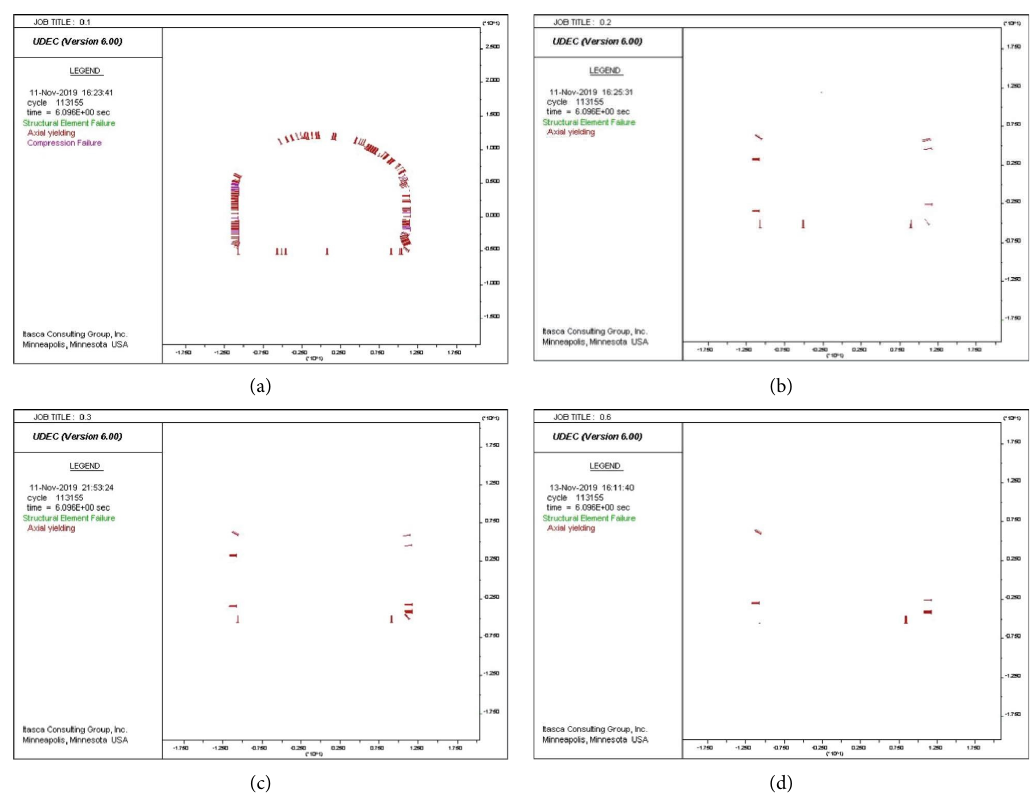
Figure 5: Stress state of shotcrete lining structure: (a) shotcrete 10cm, (b) shotcrete 20cm, (c) shotcrete 30 cm, and (d) shotcrete